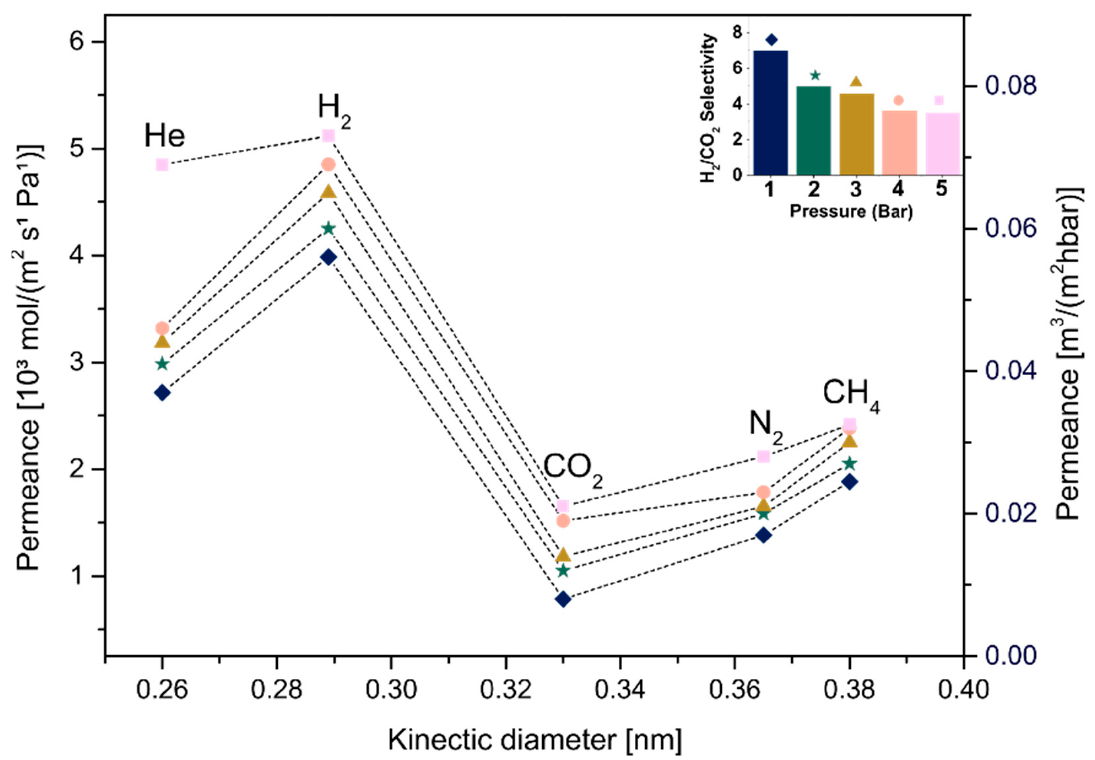
Figure 12. Single-gas permeabilities, permeances and H 2 /CO 2 selectivity under different pressures for C 1 _500.